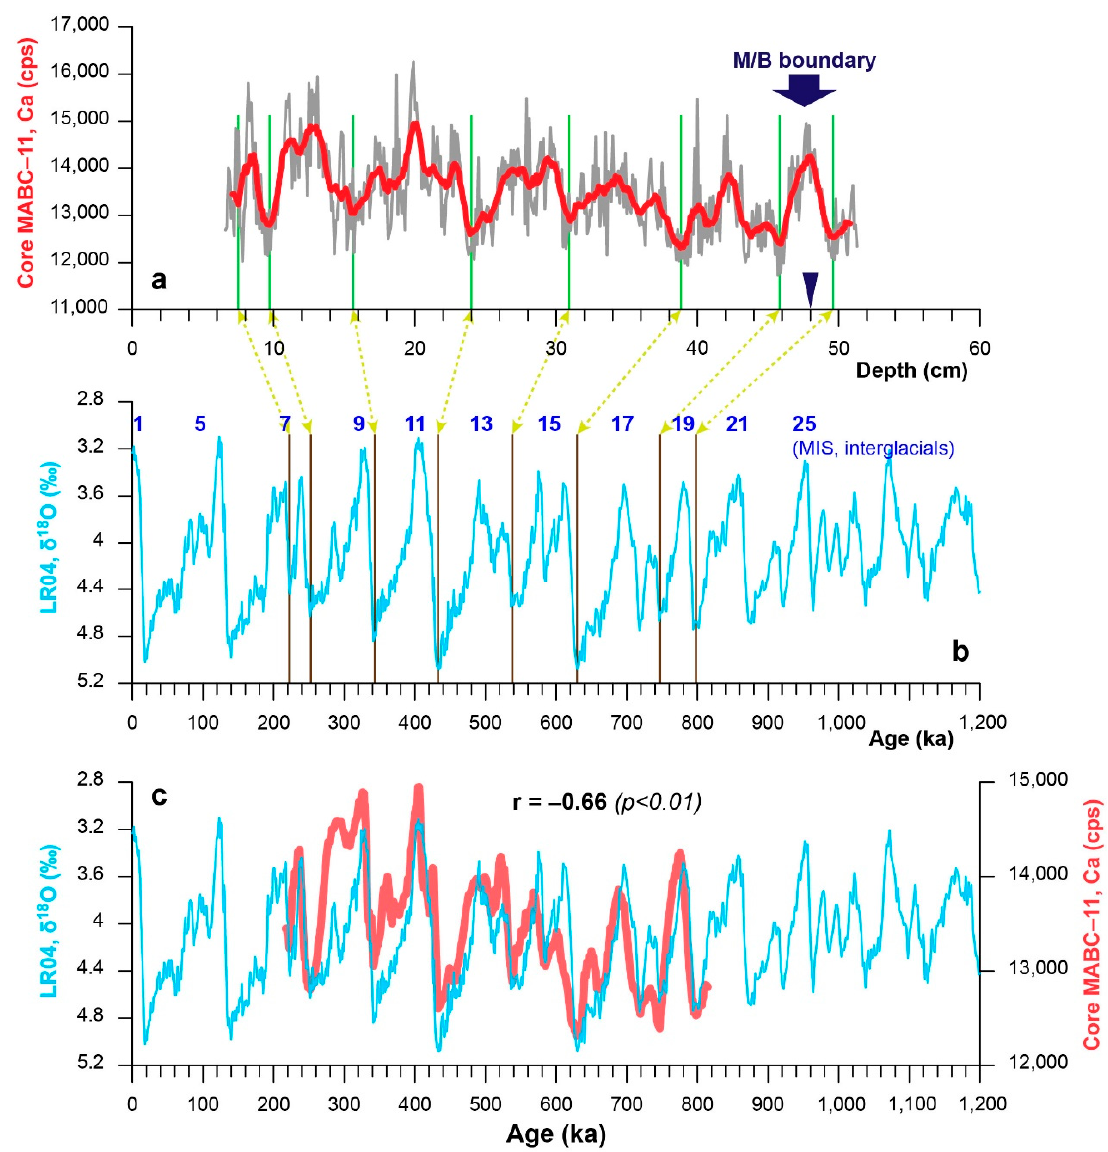
Figure 5. Tuning Ca intensity of core MABC–11 to LR04 δ 18 O record. ( a ) Ca record with the nine-point moving average of core MABC–11. ( b ) Benthic δ 18 O stack LR04 [50]; ( c ) Comparison between Ca and LR04 records on glacial-interglacial timescales.